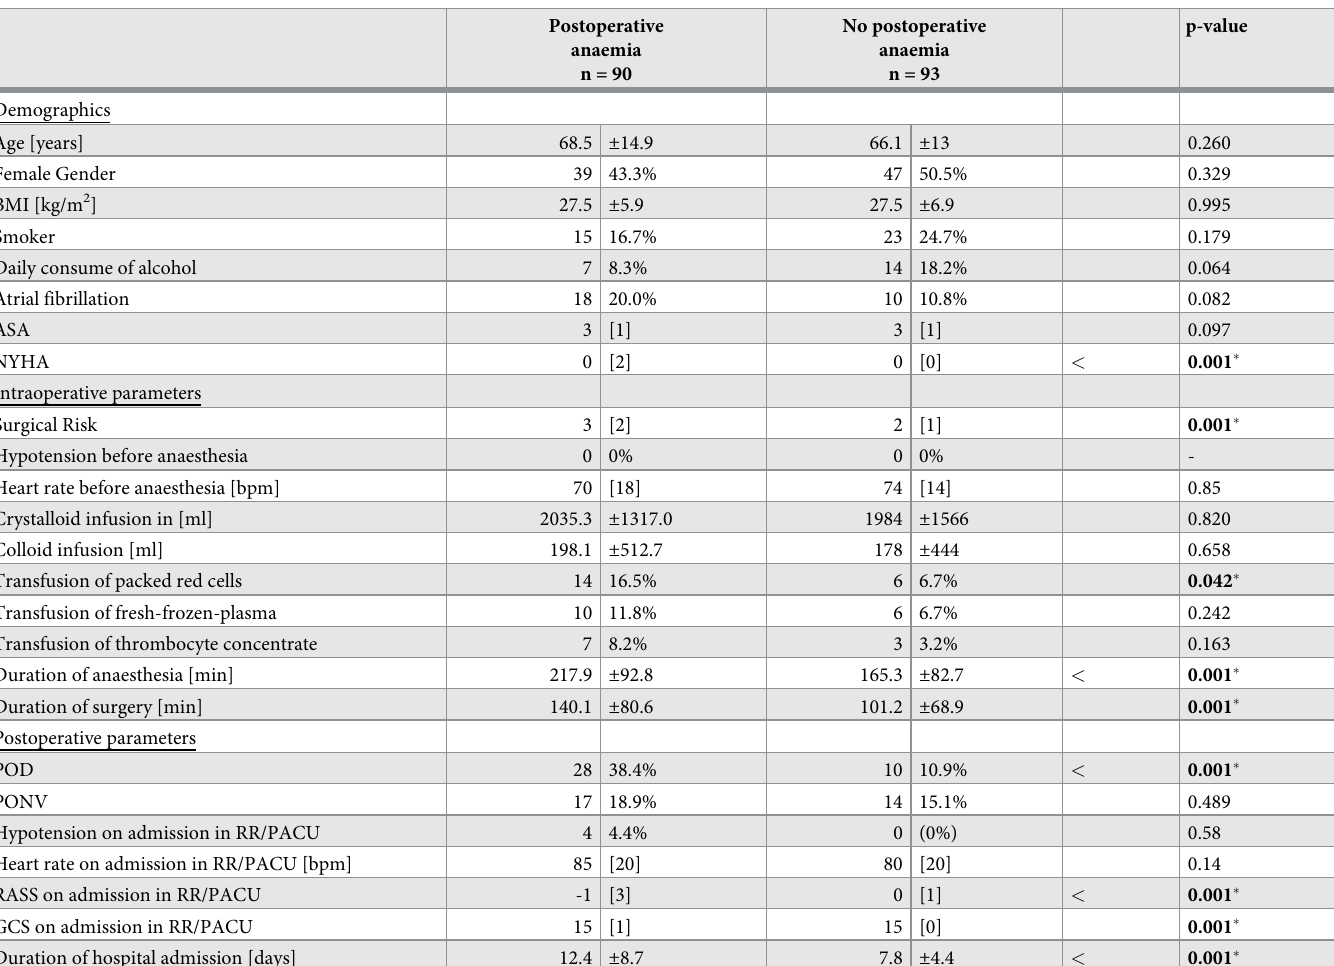
Table 1. Characteristics of all included